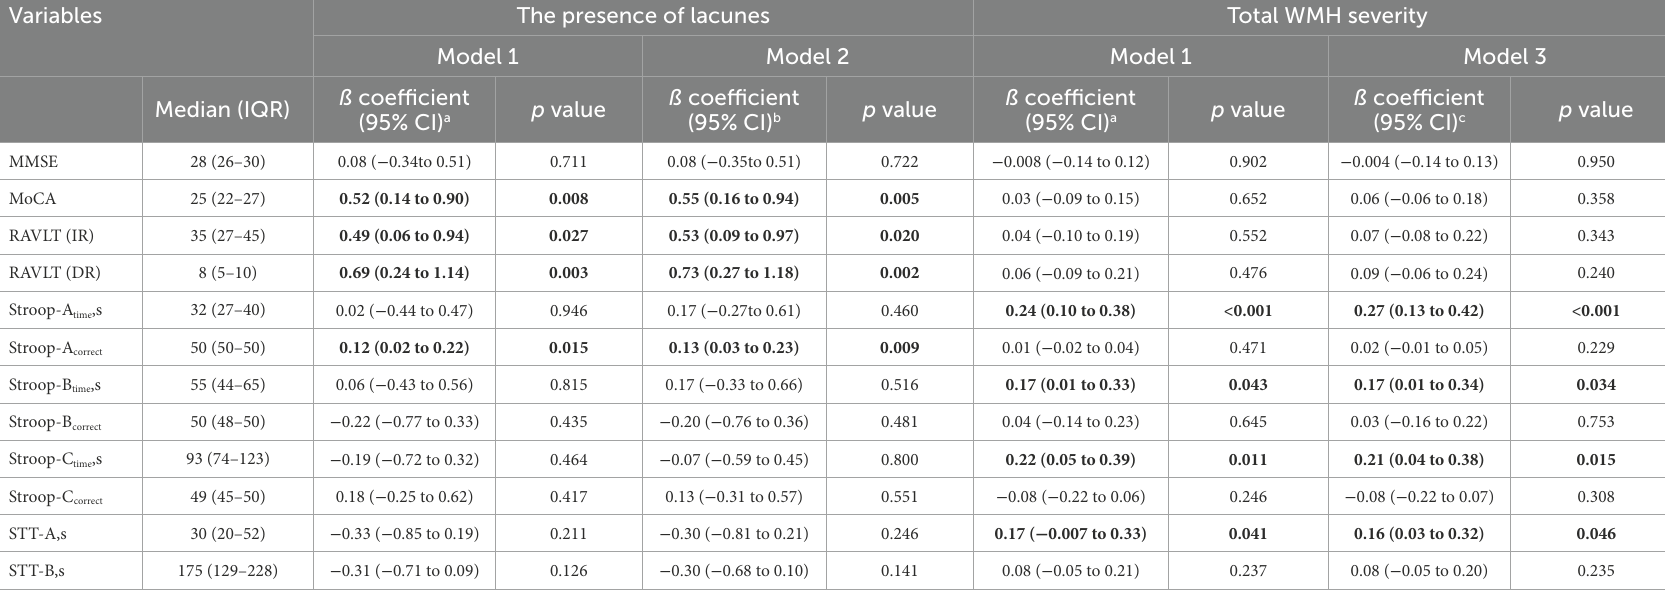
TABLE 3 Correlation between SVD imaging markers and standardized cognitive measures in generalized linear models.